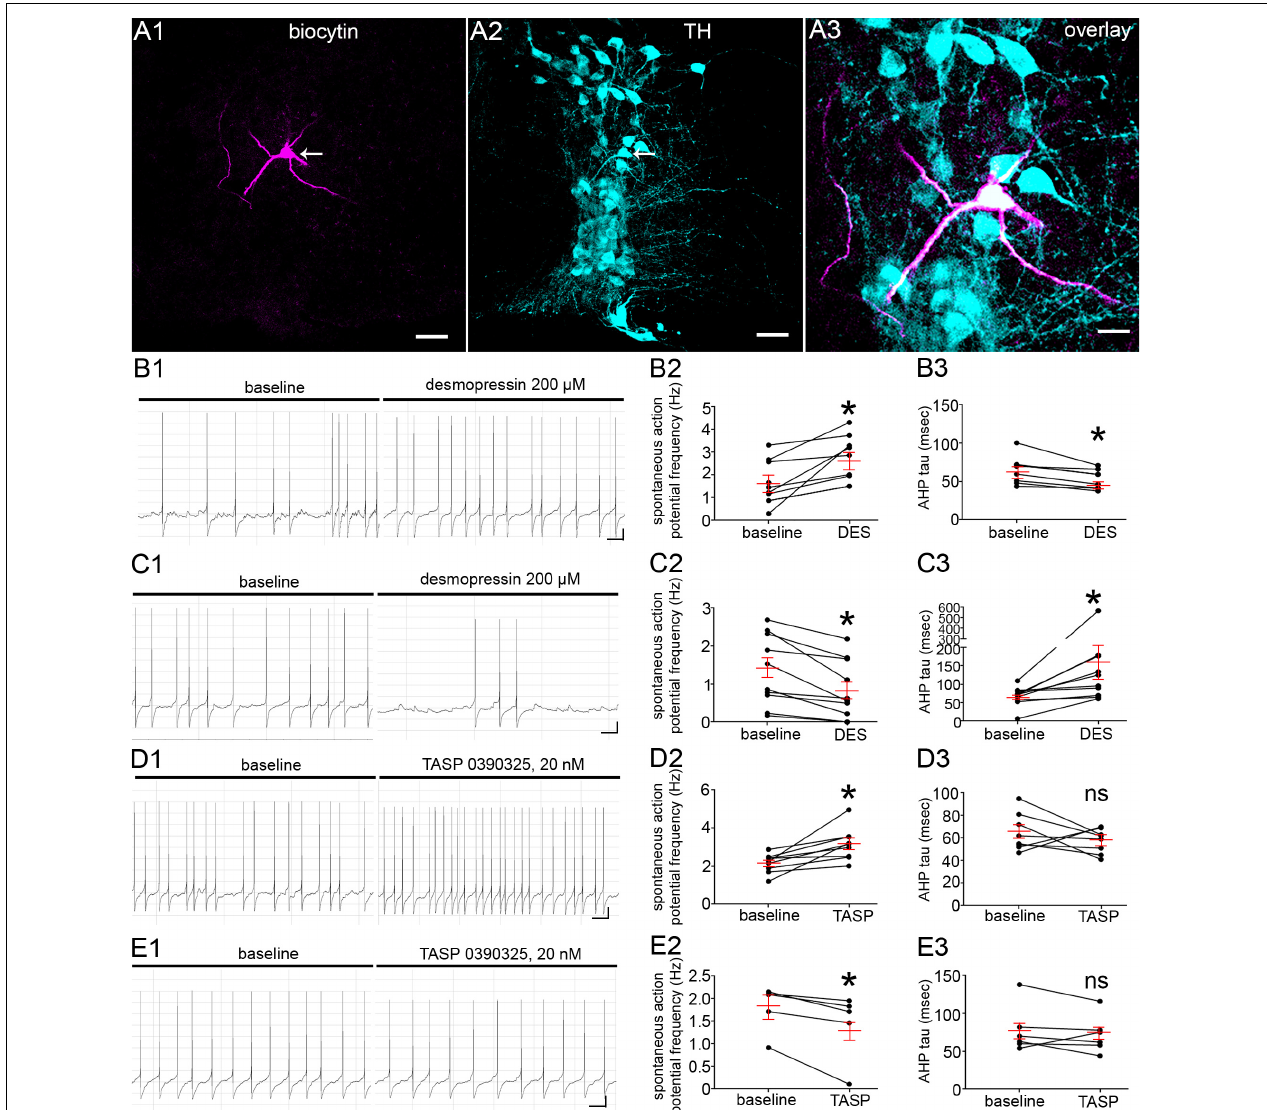
FIGURE 3 | V1b receptor modulation directly alters LC noradrenergic neuronal activity. (A) Post hoc microscopical confirmation of the molecular identity and location of recorded neurons. (A1) Shows immunoreactivity for biocytin which was originally contained within the intracellular solution used for recording the neuron in the whole-cell configuration. Note that immunoreactivity is located exclusively within the single neuron (arrow). (A2) Shows immunoreactivity for TH within the same filed of view as (A1) , confirming that the recording was from the LC, with the arrow highlighting the recorded cell. (A3) Is an overlay and magnified view the cell in (A1,A2) confirming that the recorded cell is TH immunopositive and thus a noradrenergic LC neuron. (B1) Representative traces of the spontaneous firing pattern of an LC neuron before and after the application of the V1b receptor agonist desmopressin 200 µ M, from a cohort of neurons that responded with a significant increase in the frequency of spontaneous action potentials. (B2) Quantification of the spontaneous firing rates (Hz) of LC neurons before and after the application of desmopressin (DES). (B3) Quantification of the after hyperpolarization time constant (msec) of LC neurons before and after the application of desmopressin. (C1) representative traces of the spontaneous firing pattern of an LC neurons before and after the application of the V1b receptor agonist desmopressin 200 µ M, from a cohort of neurons that responded with a significant decrease in the frequency of spontaneous action potentials. (C2) Quantification of the spontaneous firing rates (Hz) of LC neurons before and after the application of desmopressin. (C3) Quantification of the after hyperpolarization time constant (msec) of LC neurons before and after the application of desmopressin. (D1) Representative traces of the spontaneous firing pattern of an LC neuron before and after the application of the V1b receptor antagonist TASP 0390325, 20 nM, from a cohort of neurons that responded with a significant increase in the frequency of spontaneous action potentials. (D2) Quantification of the spontaneous firing rates (Hz) of LC neurons before and after the application of TASP 039325. (D3) Quantification of the afterhyperpolarization time constant (msec) of LC neurons before and after the application of TASP 039325. (E1) Representative traces of the spontaneous firing pattern of an LC neuron before and after the application of the V1b antagonist TASP 0390325, 20 nM, from a cohort of neurons that responded with a significant decrease in the frequency of spontaneous action potentials. (E2) Quantification of the spontaneous firing rates (Hz) of LC neurons before and after the application of TASP 039325. (E3) Quantification of the afterhyperpolarization time constant (msec) of LC neurons before and after the application of TASP 039325. For graphs in (B–E) , the dots represent the values for individual cells, the long red bars represents the mean for all cells within that group, and the short red bars represent the SEM. ∗ p < 0.05, paired Student’s t -test. Scale bars (A1,A2) 50 µ m; (A3) 20 µ m; (B1,C1,D1,E1) horizontal bar 1 s, vertical bar 10 mV.